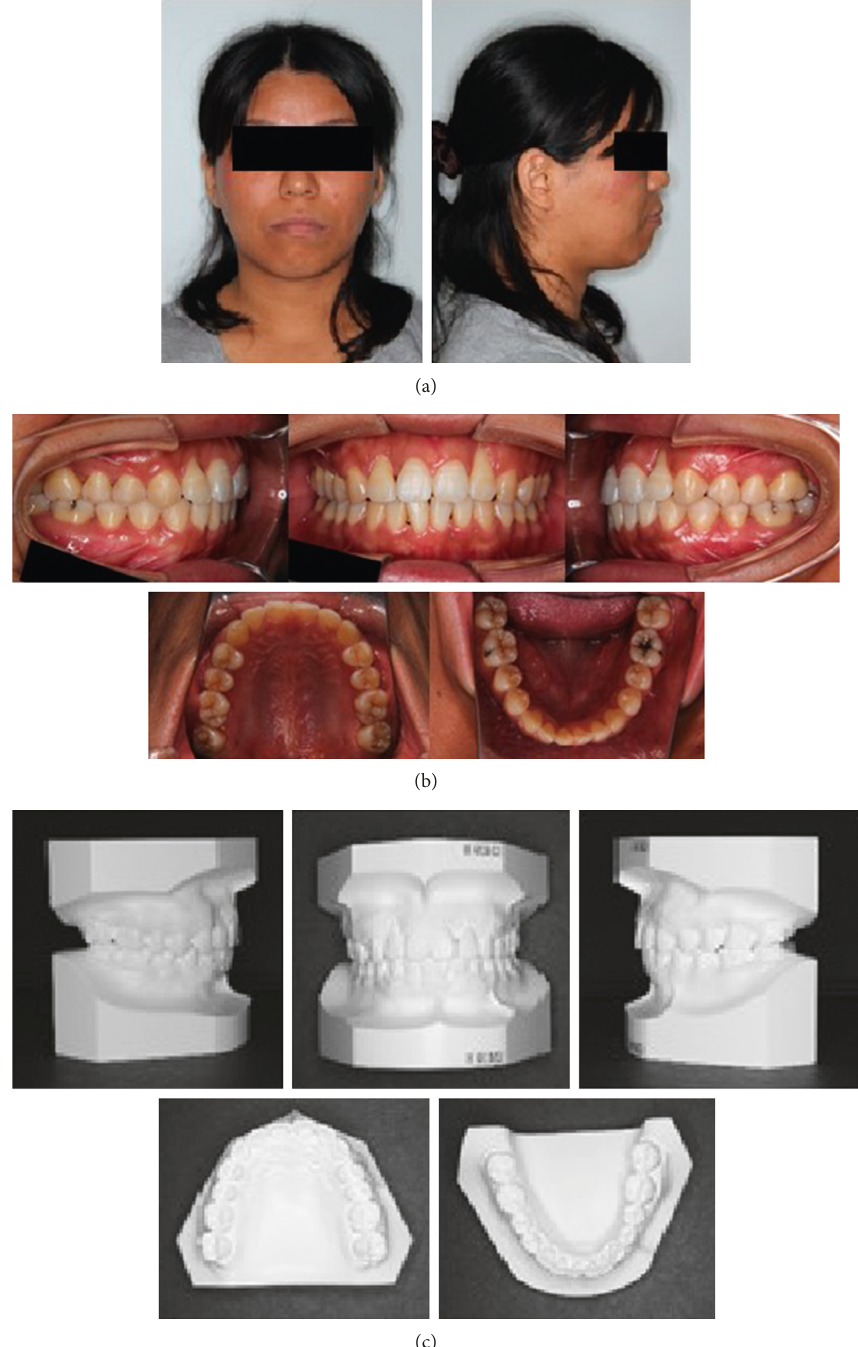
Figure 6: Post-orthodontic treatment facial (a) and intraoral photographs (b) and dental casts (c) are